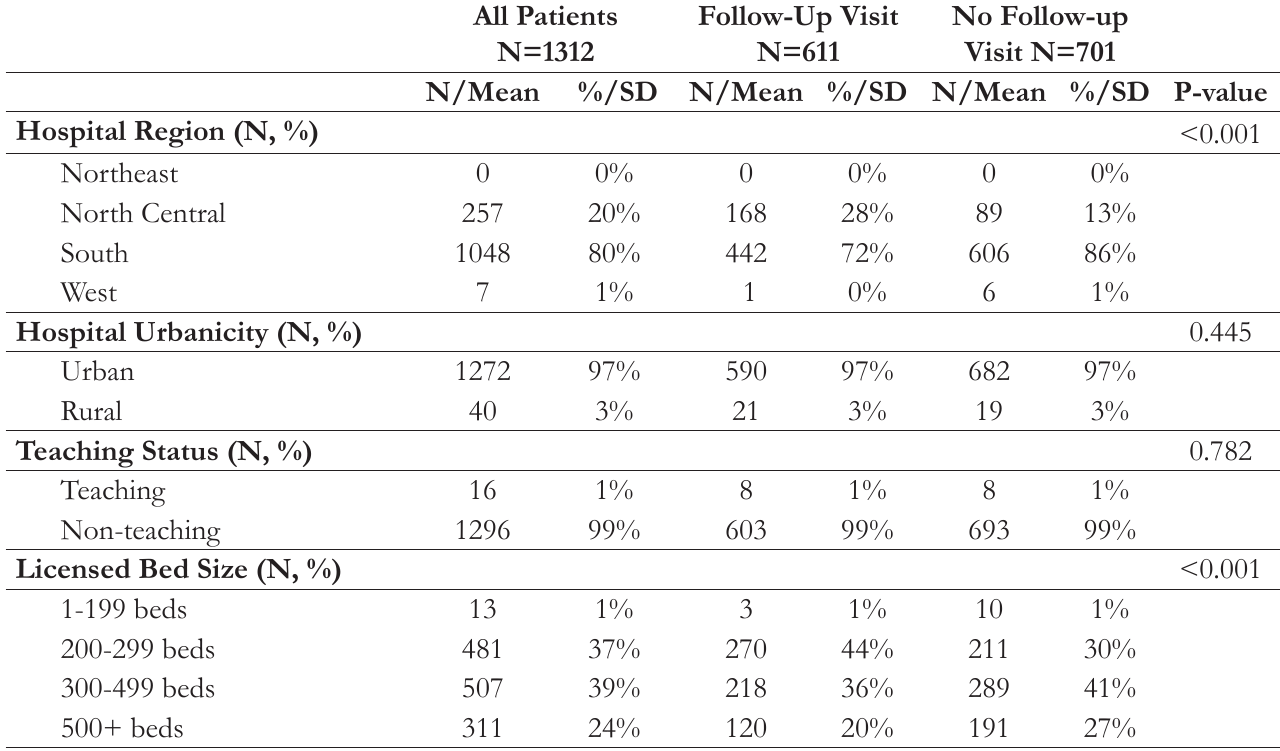
Table 3. Hospital Characteristics